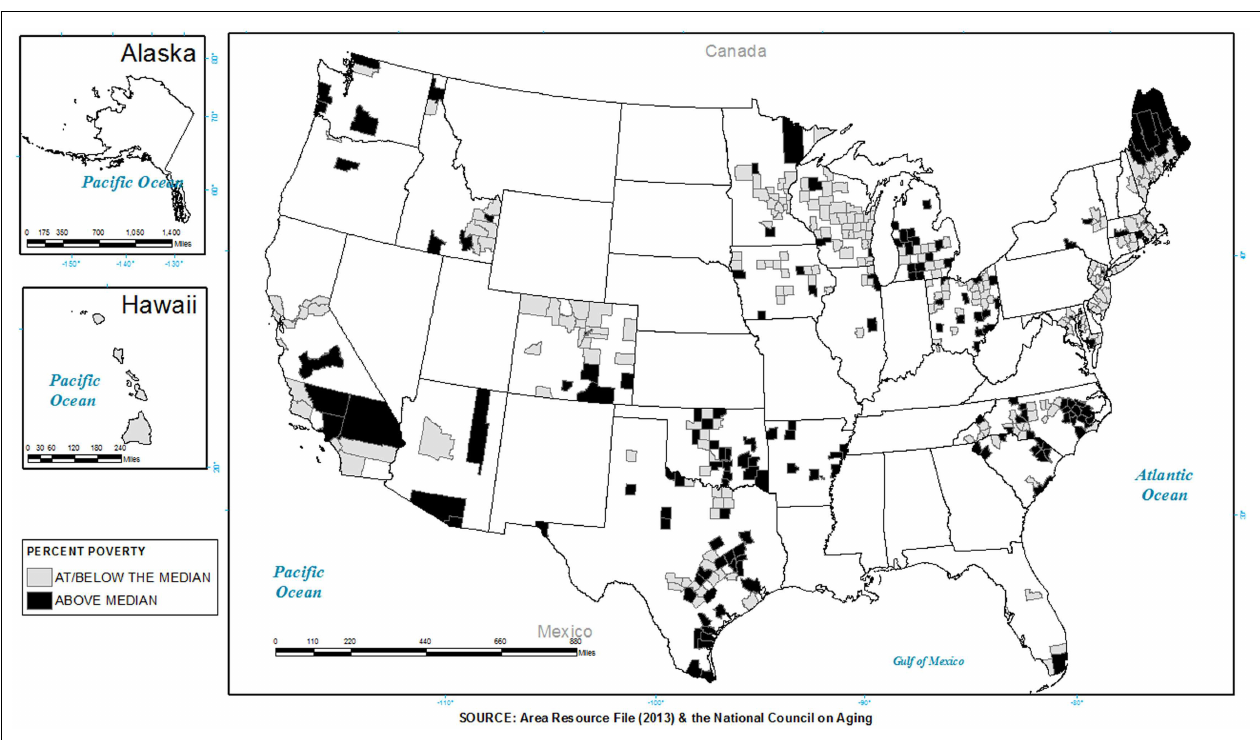
FIGURE 1 |The distribution of areas with a higher poverty rate than the median and a presence of evidence-based programs in 2006–2009